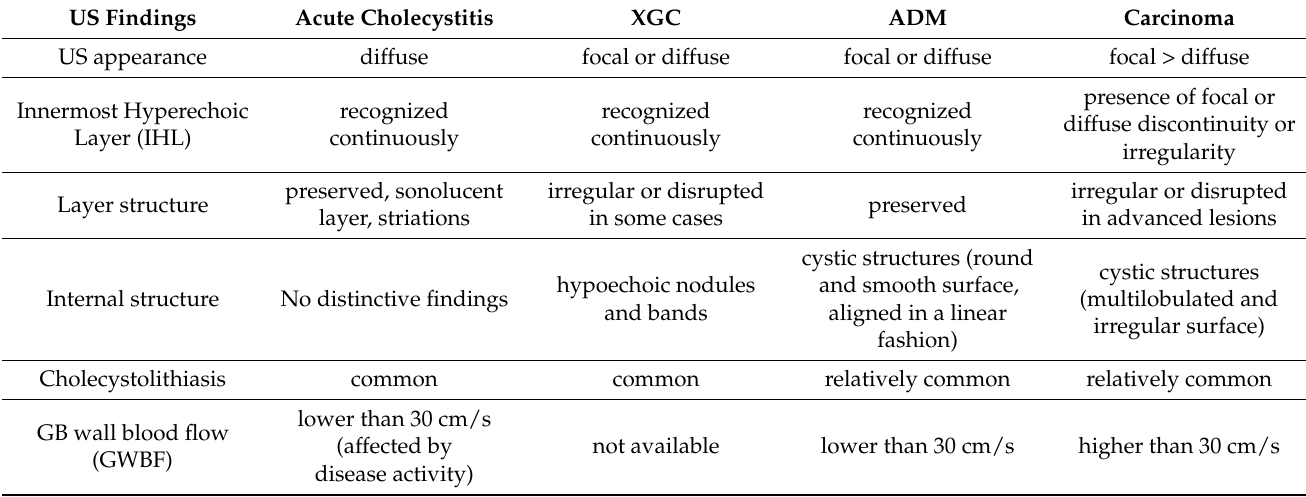
Figure 15. GWBF velocity. GWBF velocity showed 43.8 cm/s in acute cholecystitis. Table 3. US findings in major GWT.